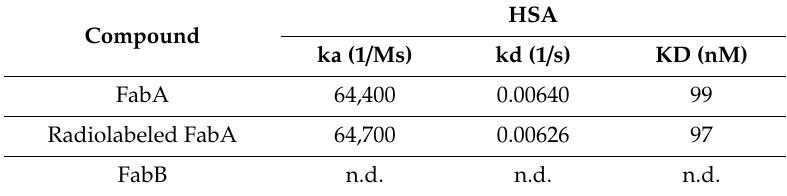
Table 4. Binding kinetics of FabA (unlabeled and radiolabeled) and FabB to HSA.